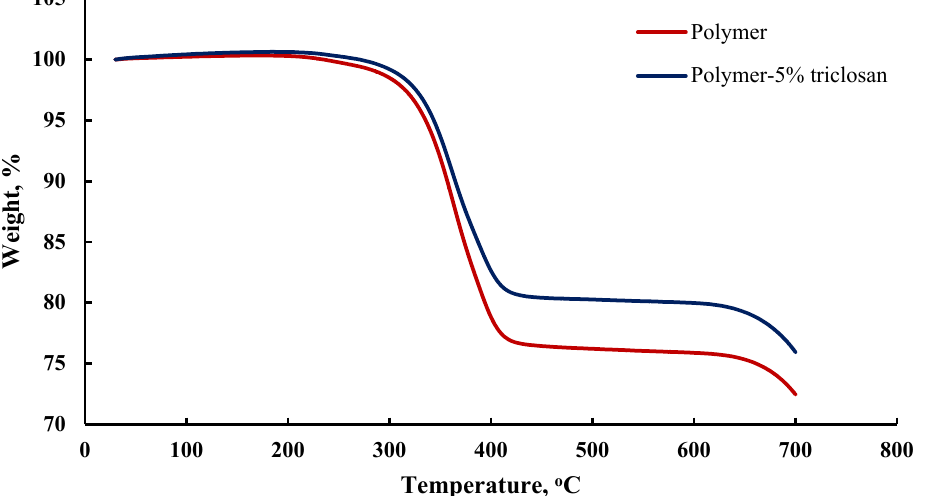
Figure 3. Thermogravimetric analysis of the pristine and 5 wt.%-triclosan-loaded polymer composites at heating rate of 10 °C/min from 50 °C to 700 °C.